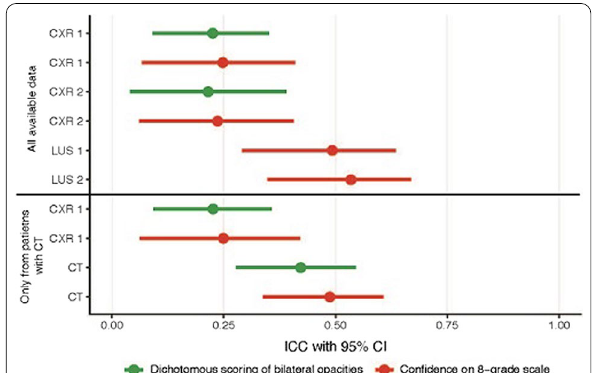
Figure 2. Agreement on scoring ARDS for all imaging modalities. ICCs with 95% confidence interval displaying the agreement for dichoto- mous scoring of bilateral opacities to diagnose ARDS and scoring of confidence for ARDS diagnosis on an 8-grade scale. Abbreviations: CI: confidence interval, CXR chest X-ray, ICC intra class correlation = = coefficient, LUS lung =